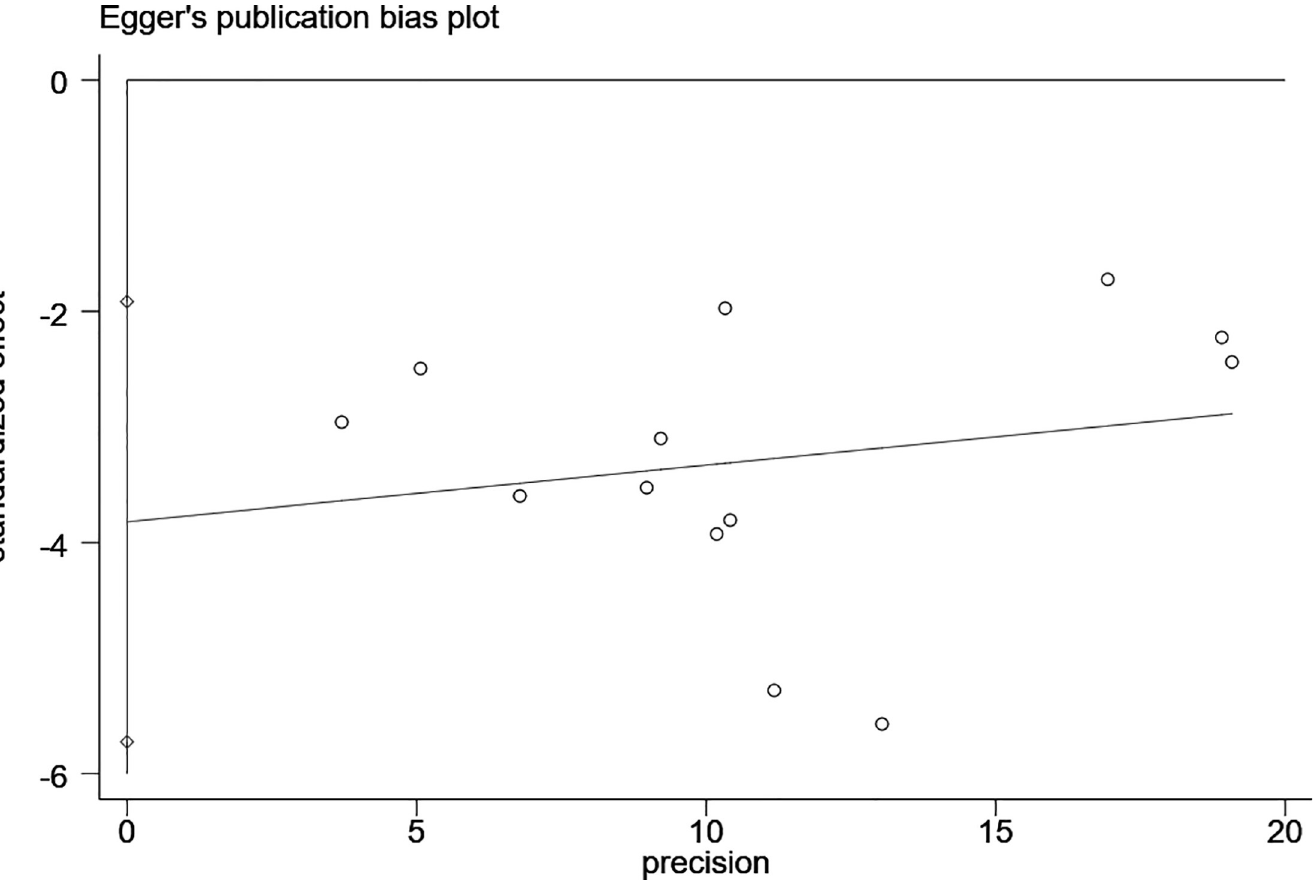
Fig 3. Egger’s plot to detect publication bias on overall